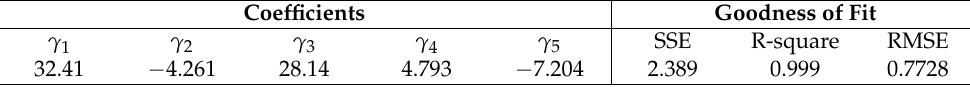
Figure 3. Relationship between the displacement and stress at the H-joint: ( a ) the geometric model of the vicinity of the H-joint, and ( b ) response surface model for the H-joint. Table 3. Parameters of the stress-displacement relationship at the H-joint.